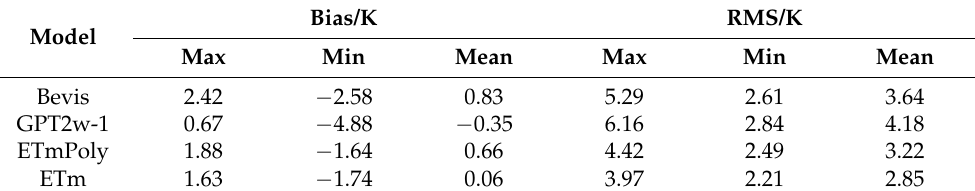
Figure 3. Bias distribution of the four Tm models at each modeling station in 2021 .